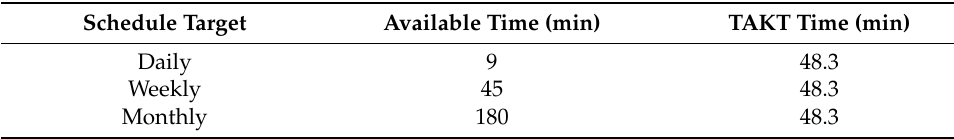
Table 2. The initial production target of the production system.